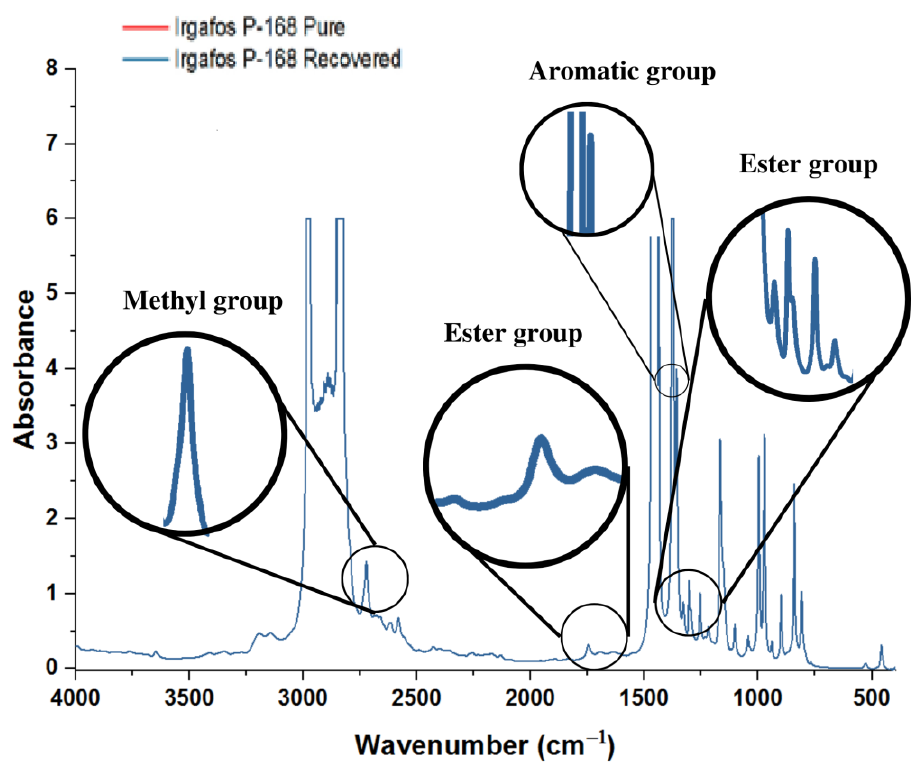
Figure 14. PP+ P-168 pure and PP + P-168 recovered. Figure 14. PP + P-168 pure and PP + P-168